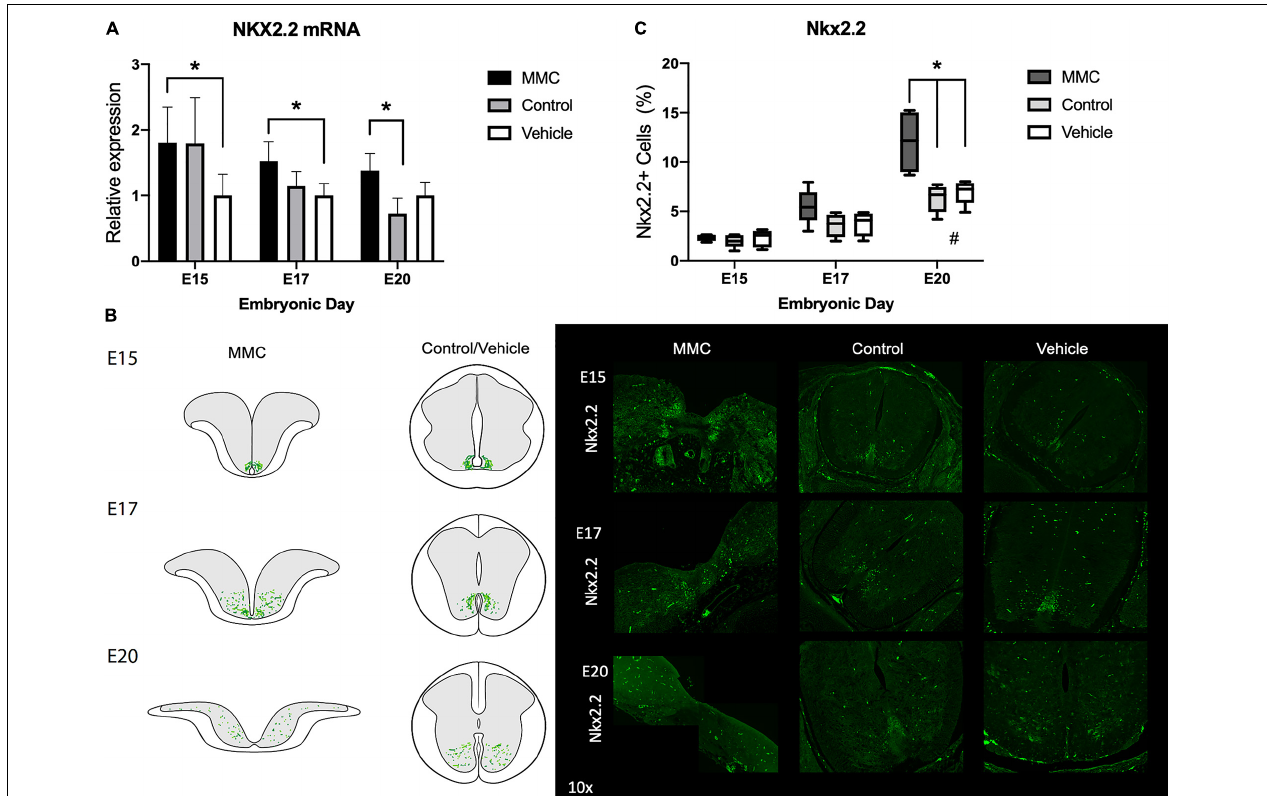
FIGURE 8 | Nkx2.2 expression and distribution in spina bifida. (A) Nkx2.2 relative expression increased in spina bifida compared with control and vehicle spinal cords at E15 and E17. Values (means ± SE, 6 fetuses/group) of relative expression (2 – (cid:49)(cid:49) Ct ) for RA-treated and time-matched controls (* p < 0.05). (B) Schematic representation of Nkx2.2 distribution in MMC and control spinal cords at E15, E17, and E20 (left). Nkx2.2+ staining in MMC, control, and vehicle spinal cords at E15, E17, and E20 (right) (10 × ). Nkx2.2 (green) immunoreactive NPC cells at E15, E17, and E20 in spina bifida (10 × ). (C) % Nkx2.2+ NPC in MMC, control, and vehicle spinal cords determined by Nkx2.2 stained cells/total cells at three gestational ages E15, E17, and E20 (means ± SD, * p < 0.005, # p < 0.05 between control and vehicle groups at E20 compared to E15 and